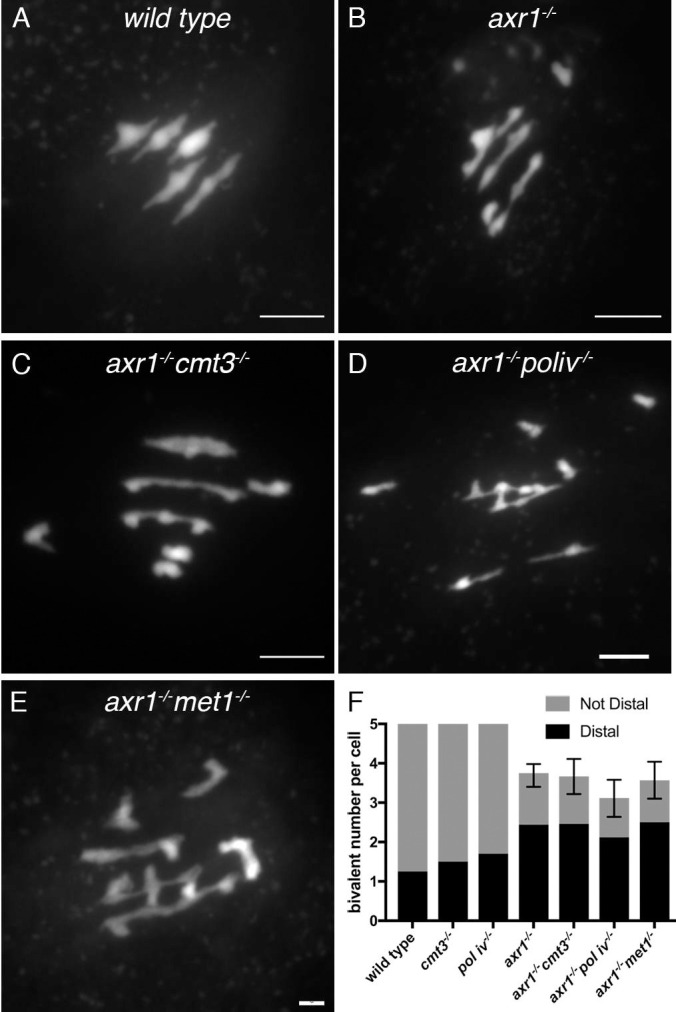
Chromosome configuration at metaphase 1.A-E: Representative examples of metaphase 1 cells from wild type (A), axr1-/- (B), the double axr1-/-
cmt3-/- (C) axr1-/-
pol iv-/- (E) and axr1-/-
met1-/- (F). G: mean number of bivalents per cells with the chiasma localization (Error bars: Upper and Lower 95% Confidence Intervals).